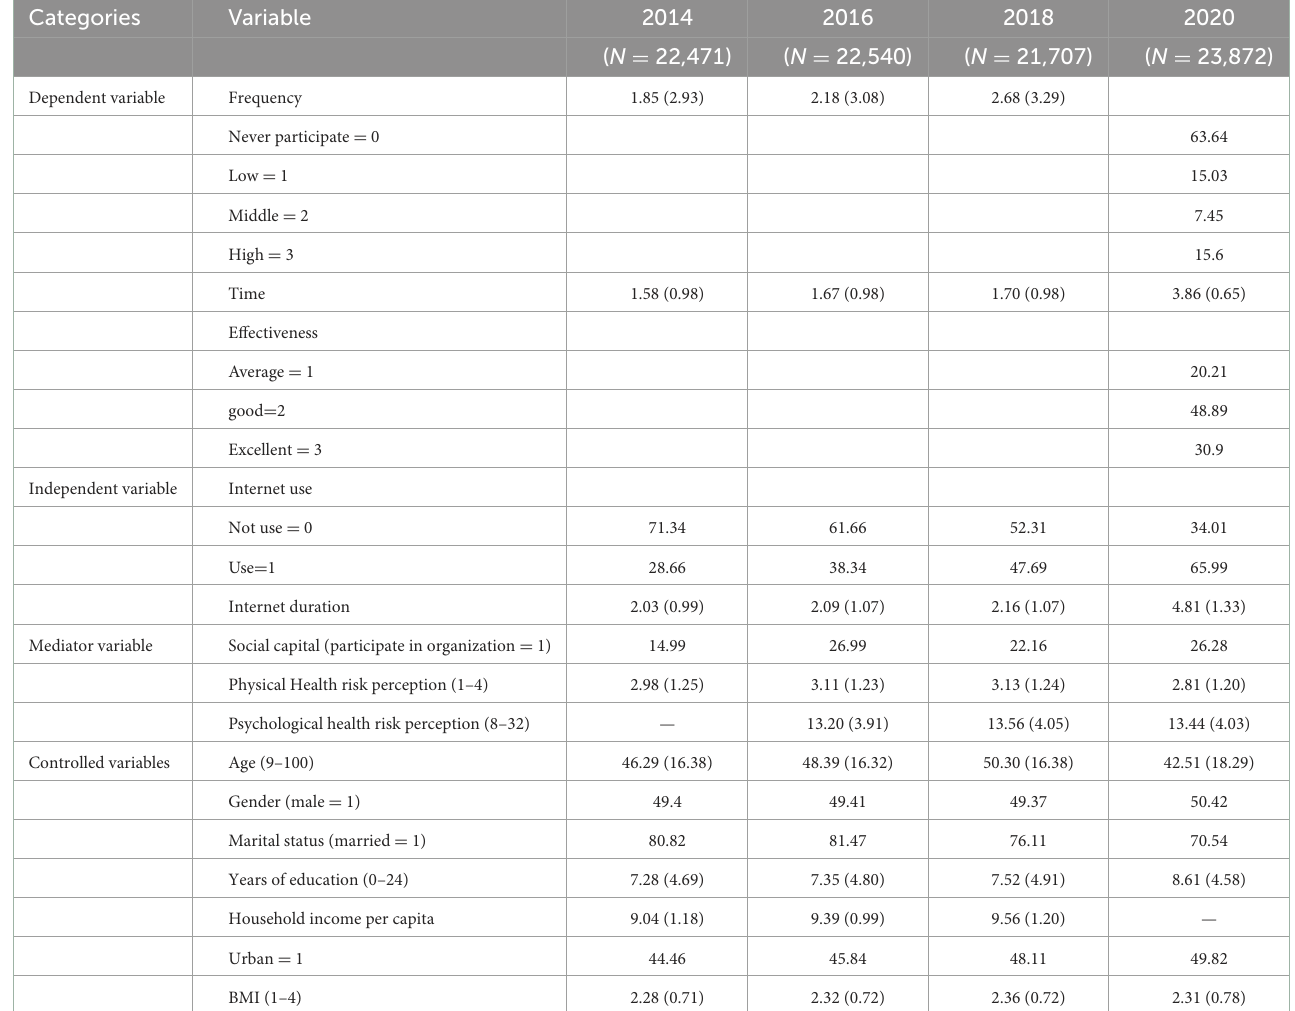
TABLE 1 Descriptive statistical results of